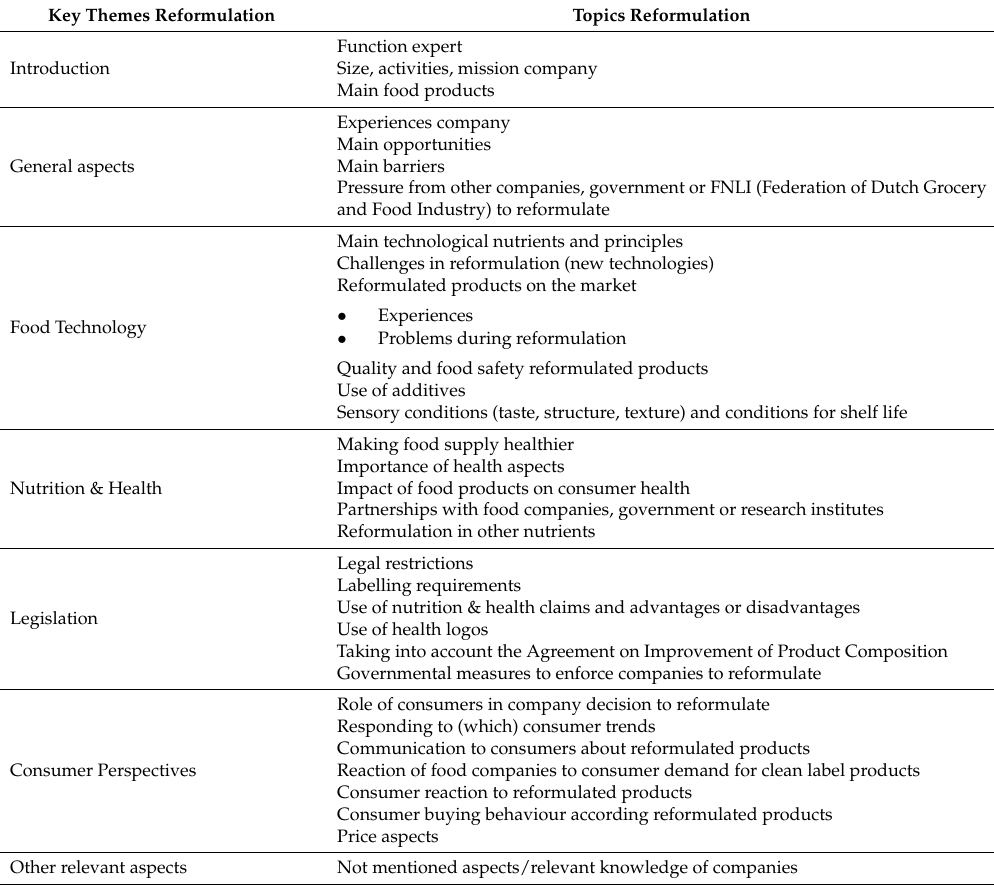
Table 2. List of key themes and topics on reformulation (salt, saturated fat, sugar) for interviews in food